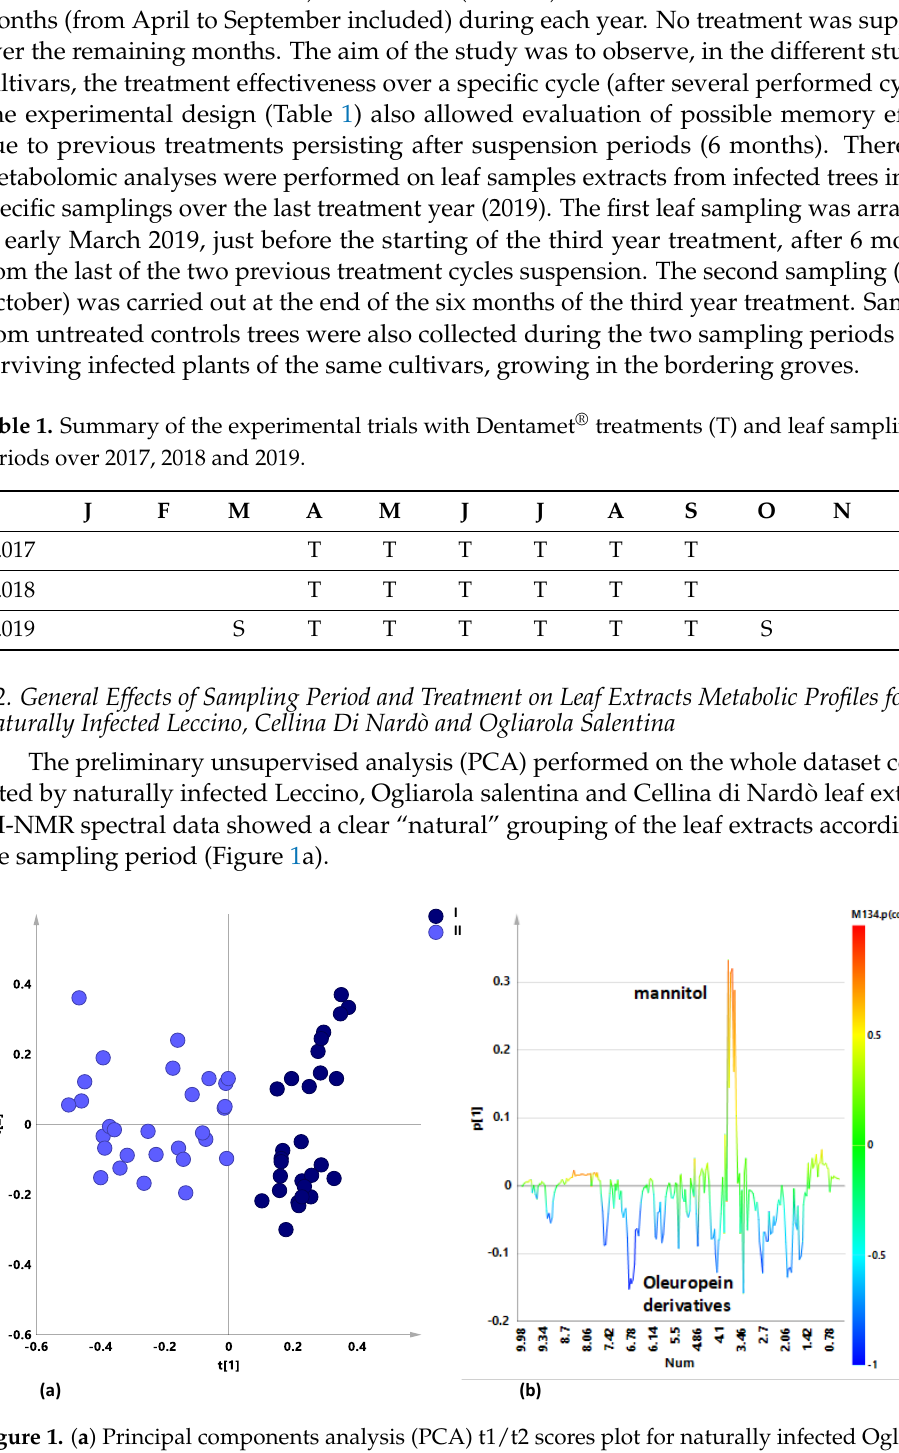
Figure 1. ( a ) Principal components analysis (PCA) t1/t2 scores plot for naturally infected Ogliarola salentina, Cellina di Nardò and Leccino leaf samples. Symbols were colored according to the sampling periods. ( b ) Line plot for the model, indicating the 1 H-NMR chemical shifts of the signals, characteristic of specific metabolites, discriminating the classes along t[1] and colored according to the correlation-scaled loading